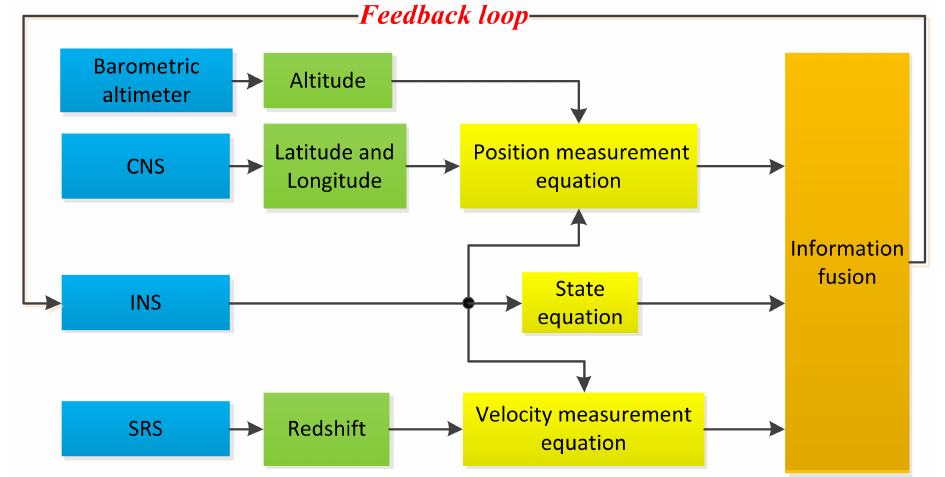
Figure 1. Structure of the inertial navigation system (INS) / spectral redshift navigation system (SRS) / celestial navigation system (CNS) integrated navigation